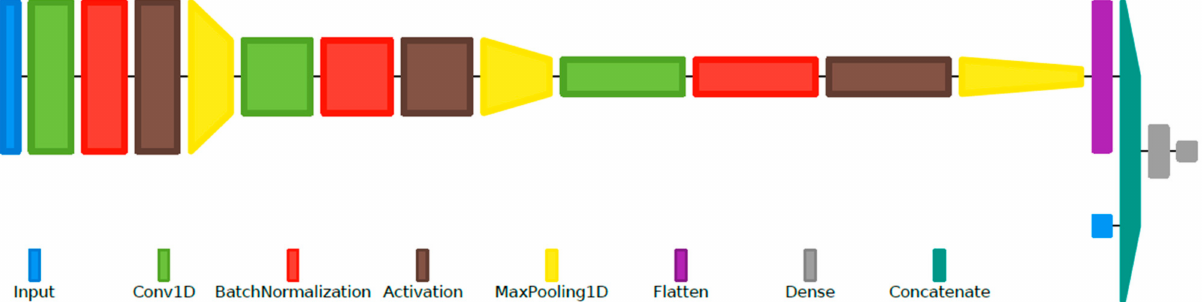
Figure 5. Layer diagram representation of the final hybrid CNN-MLP-based VAD system, using the same configuration example as in Figure